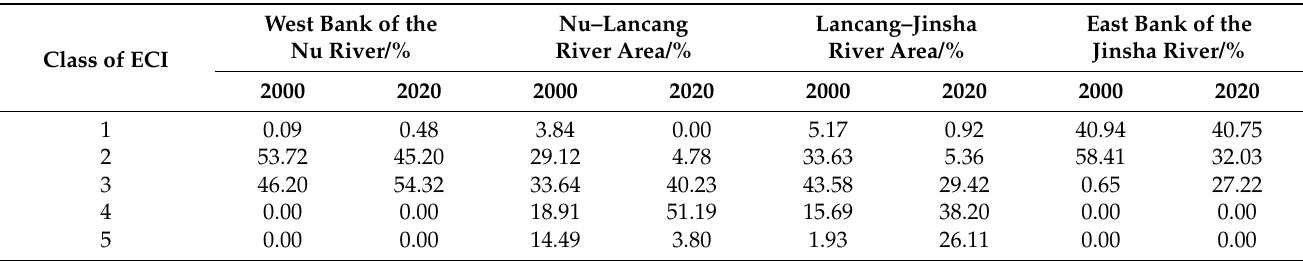
Table 8. Results of ECI classification in the four parts of the Three Parallel Rivers Natural World Heritage